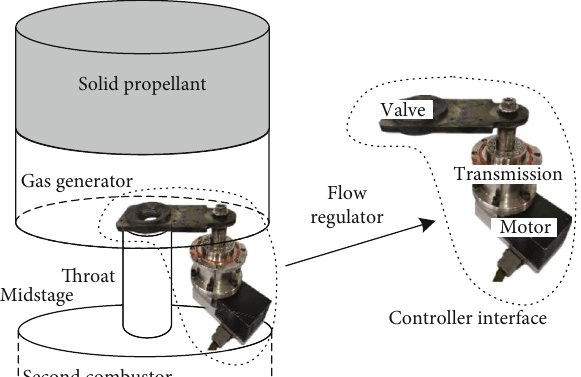
Figure 2: Schematic of the fl ow regulator using a gate